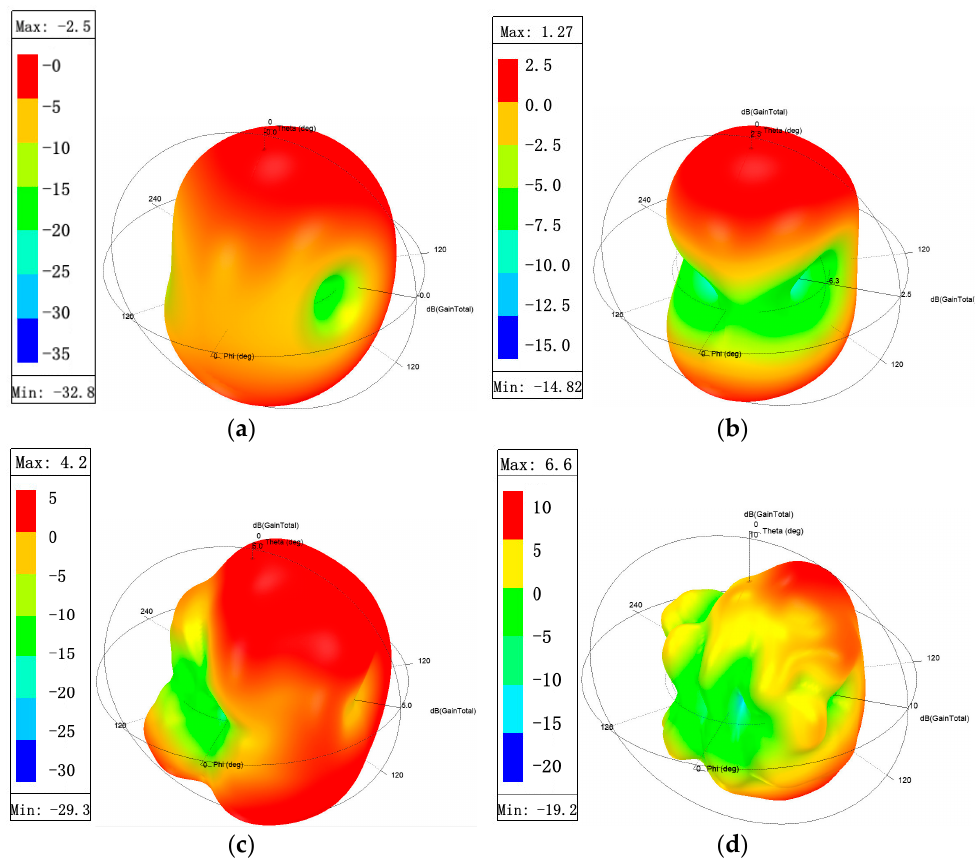
Figure 13. Three-dimensional radiation patterns of proposed MIMO antenna at: ( a ) 3 GHz; ( b ) 6.16 GHz; ( c ) 10.6 GHz; ( d ) 14.92 GHz.